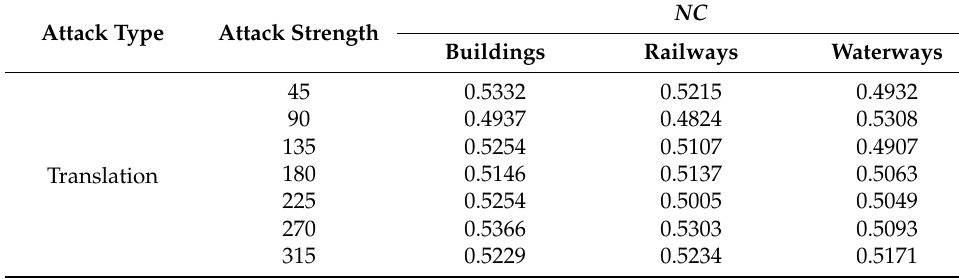
Table 11. The robustness results of rotation